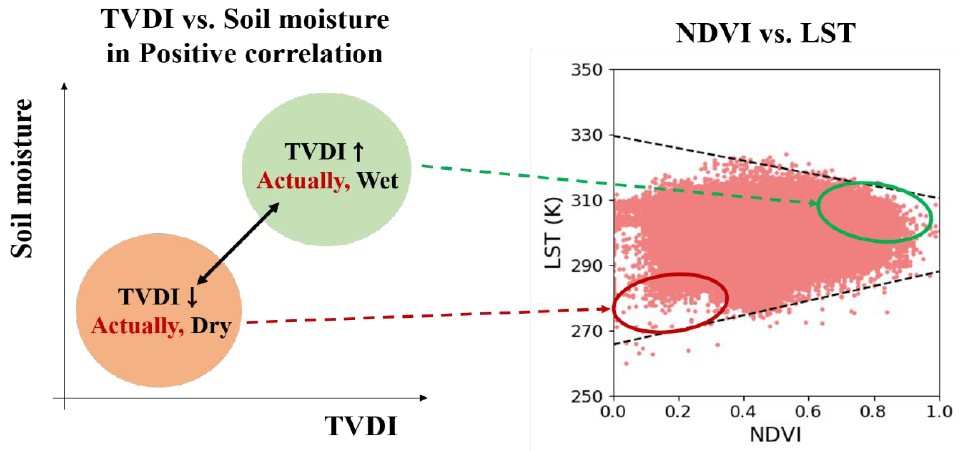
Figure 14. Positively correlated distributions in the NDVI / LST space of TVDI .